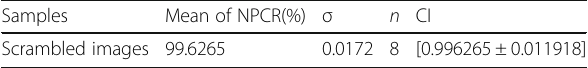
Table 6 Confidence intervals